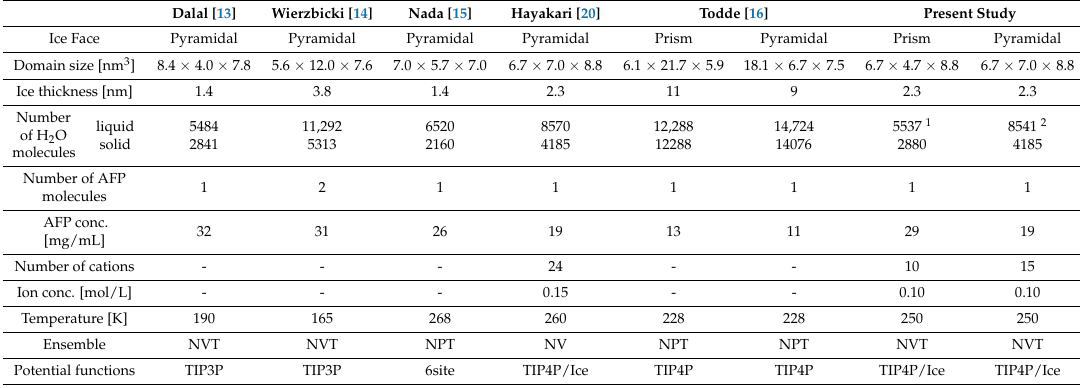
Table 4. Comparison of computational